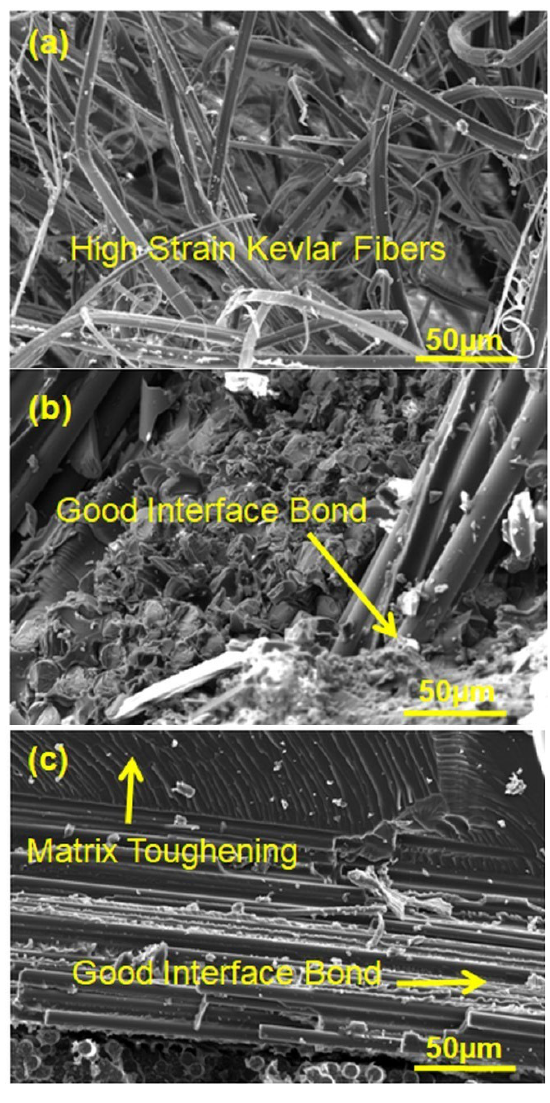
Figure 8. SEM images of the fractured surface of plain ( a ) F, ( b ) G, and ( c ) H.